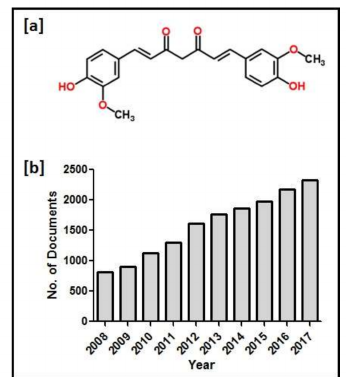
Figure 1. ( a ) Chemical structure of curcumin; and ( b ) annual publication history of curcumin